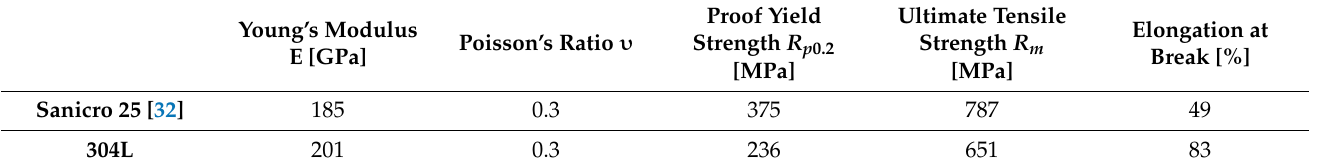
Figure 7. Finite element model used for the optimization of the fatigue crack front shape. Table 3. Basic mechanical properties of both materials.